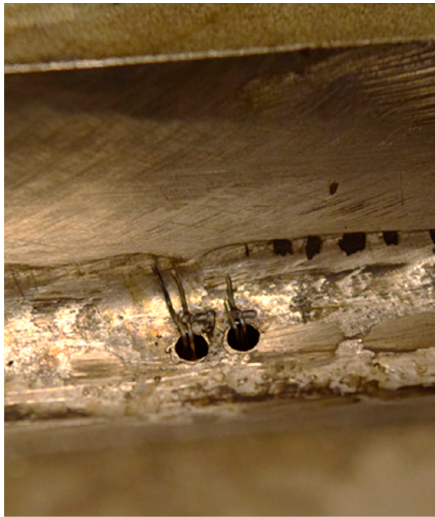
Figure 3. Example of two inserted thermocouples to register temperatures in Weld Pass 2. Holes of 2 mm in diameter were used to insert the thermocouples from the backside by drilling through the root pass. After the insertion, the thermocouples were spot welded on the surface of the joint—in this case, the surface of the root pass.